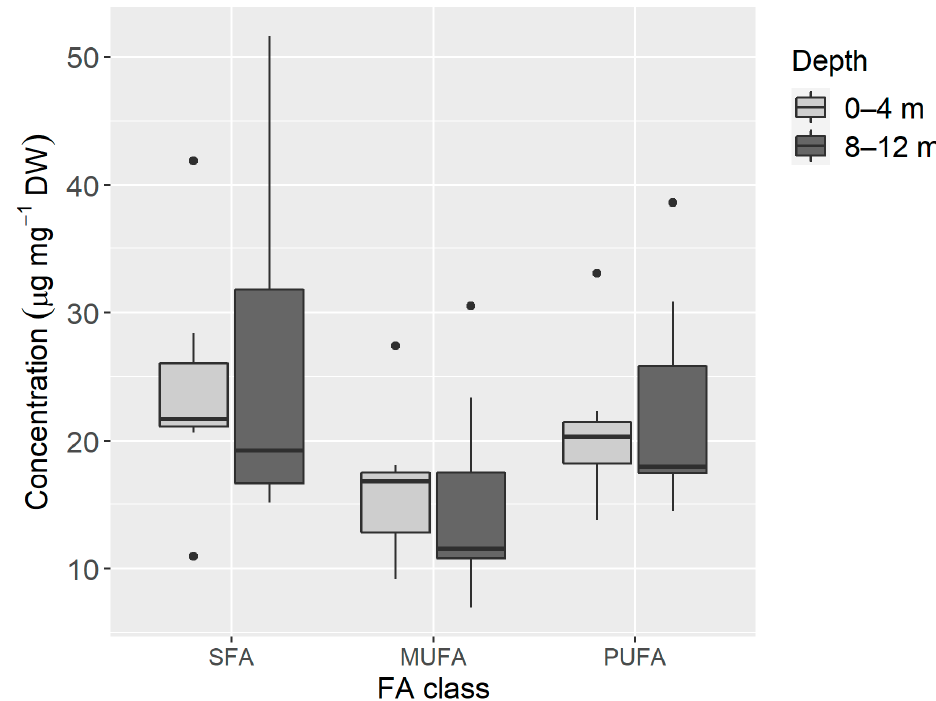
Figure 7. Concentrations of fatty acid (FA) classes from samples of Elysia crispata collected at 0–4 m ( n = 7) and 8–12 m ( n = 7) depths, in the Southern Gulf of Mexico. The line represents the median, top and bottom of the box are the 25th and 75th percentiles. The whiskers represent the maximum and minimum values, and dots are outliers. SFA—Saturated fatty acids; MUFA—Monounsaturated fatty acids; PUFA—Polyunsaturated fatty acids.